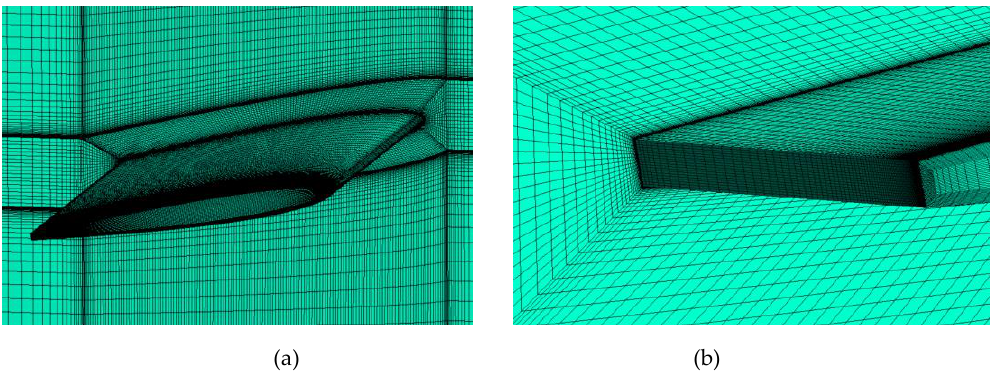
Figure 4. Mesh arrangement. ( a ) Grids on hydrofoil; ( b ) Local mesh refinement.